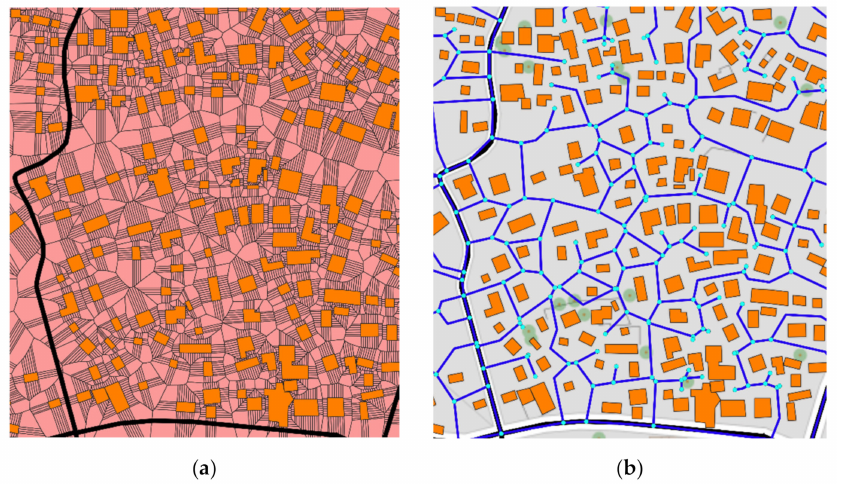
Figure 4. ( a ) The shacks (orange) are the starting position for the formation of Voronoi polygons. ( b ) Possible routes (blue) are derived from the Voronoi edges. For network modeling, nodes (cyan) are inserted at line intersections (basemap and buildings/polygons: